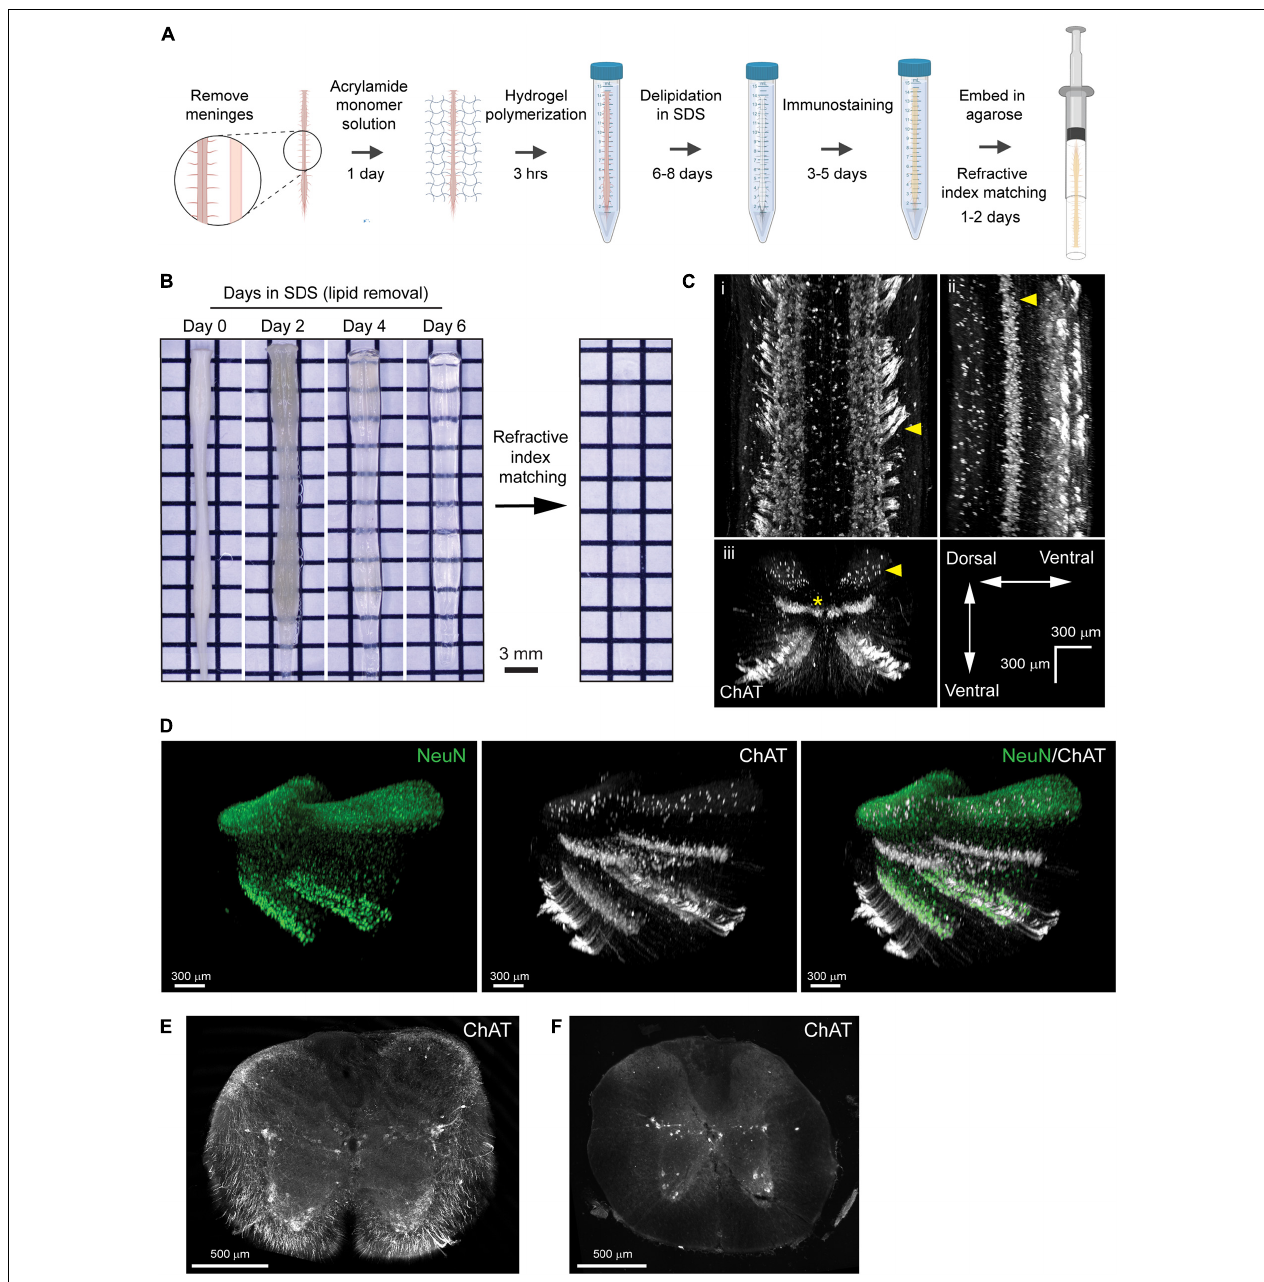
FIGURE 1 | Optimization of PACT procedures enables efficient clearing and IF labeling of the murine spinal cord. (A) Schematic of the optimized PACT clearing and IF labeling procedures. Created with BioRender. (B) Macroscopic images of tissue clearing of an intact spinal cord from a C57Bl/6 mouse with the optimized PACT procedures. (C) 3D projections of ChAT IF labeling with the optimized PACT protocol in the thoracic mouse spinal cord from dorsal (i) , sagittal (ii) , and transverse (iii) views. Arrows indicate motor axons, cholinergic neurons in the intermediate zone, and dorsal cholinergic interneurons, respectively. Asterisk indicates putative V0c interneurons in the medial region of the intermediate zone. (D) 3D projection of NeuN (green) and ChAT (white) IF labeling in the cleared thoracic mouse spinal cord. (E) Image of a vibratome section from cleared thoracic spinal cord tissue with ChAT (white) IF labeling that was performed in the whole cleared spinal cord prior to sectioning. (F) Image of traditional IF labeling for ChAT (white) performed on cryosections from thoracic spinal cord tissue that was not cleared. ChAT, choline acetyl transferase; IF,